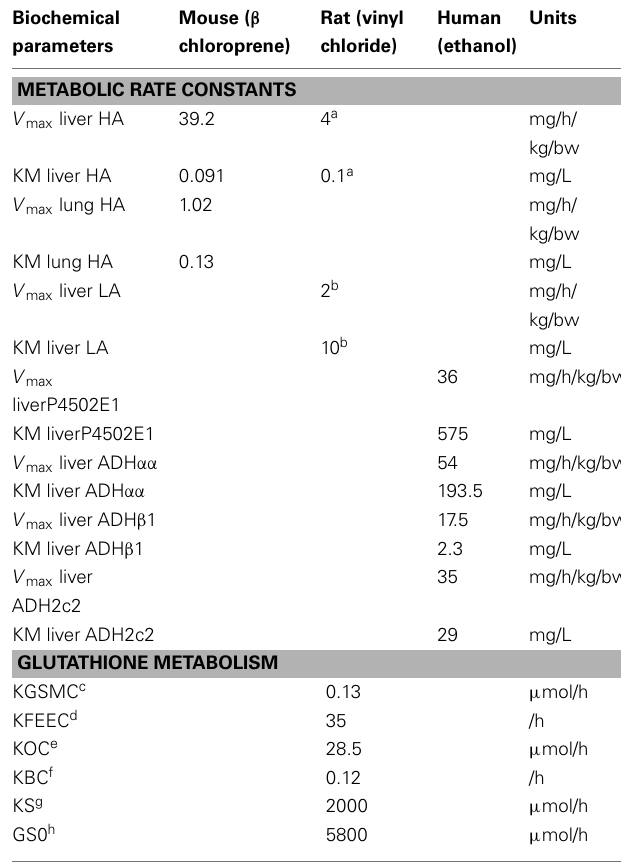
Table 4 | Metabolic parameters used in the three PBPK